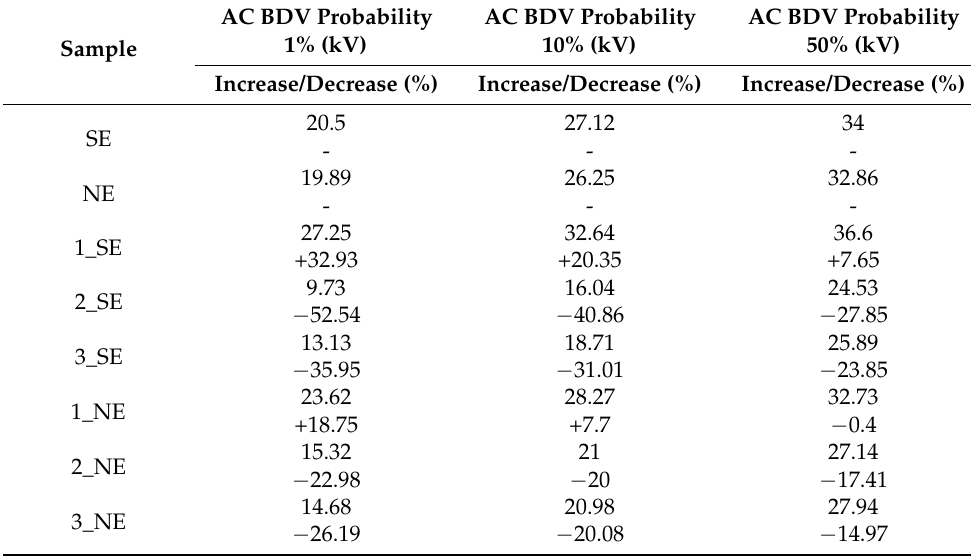
Table 5. Mean values, standard deviation, and change of examined